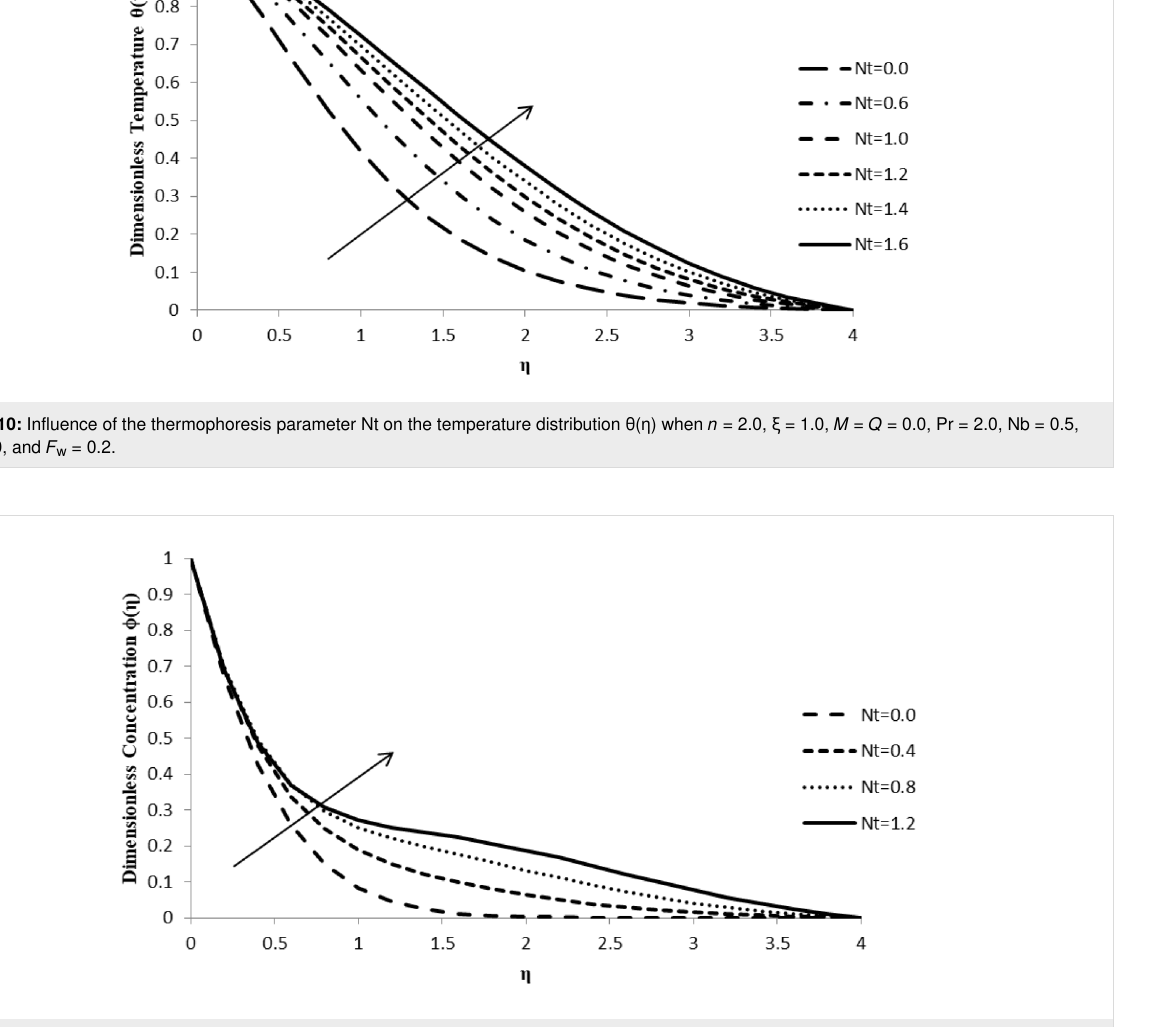
Figure 11: Influence of the thermophoresis parameter Nt on the concentration distribution ϕ ( η ) when n = 2.0, ξ = 1.0, M = Q = 0.0, Pr = 2.0, Nb = 0.5, Le = 5.0, and F w =